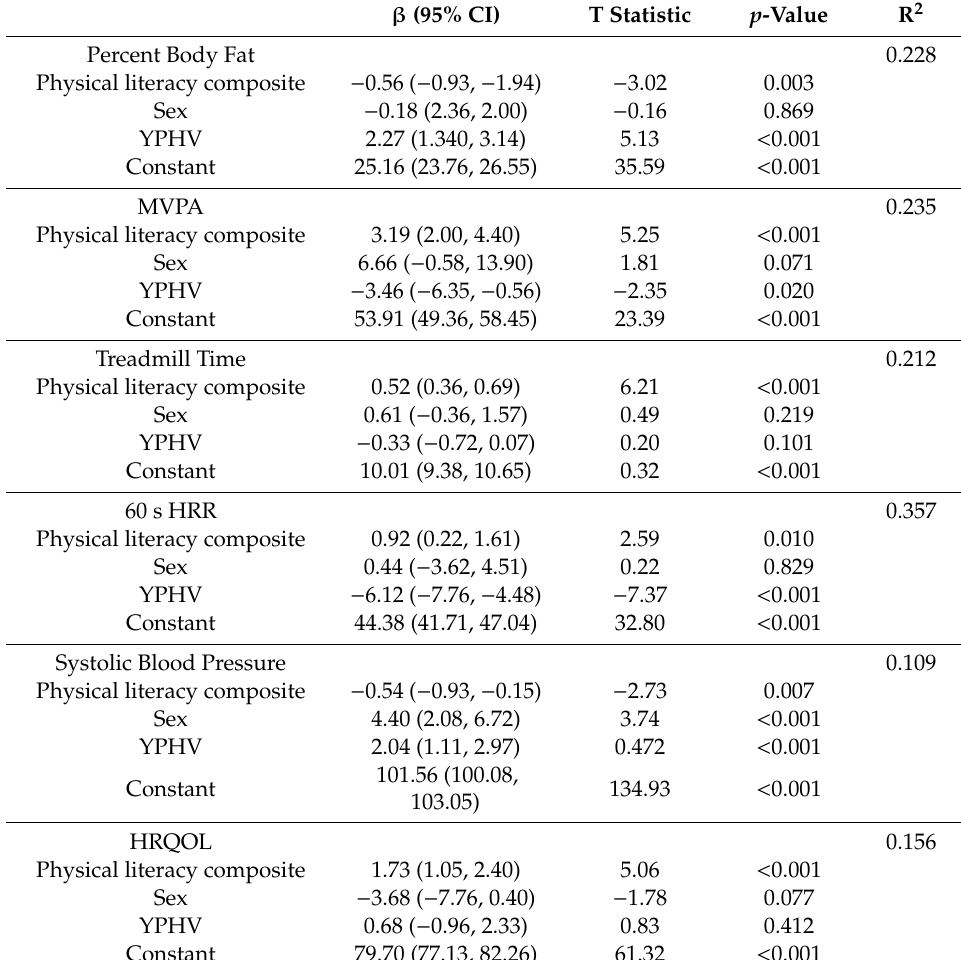
Table 3. Associations between physical literacy composite score and percent body fat, physical activity, aerobic fitness, blood pressure, and HRQOL. β (95%